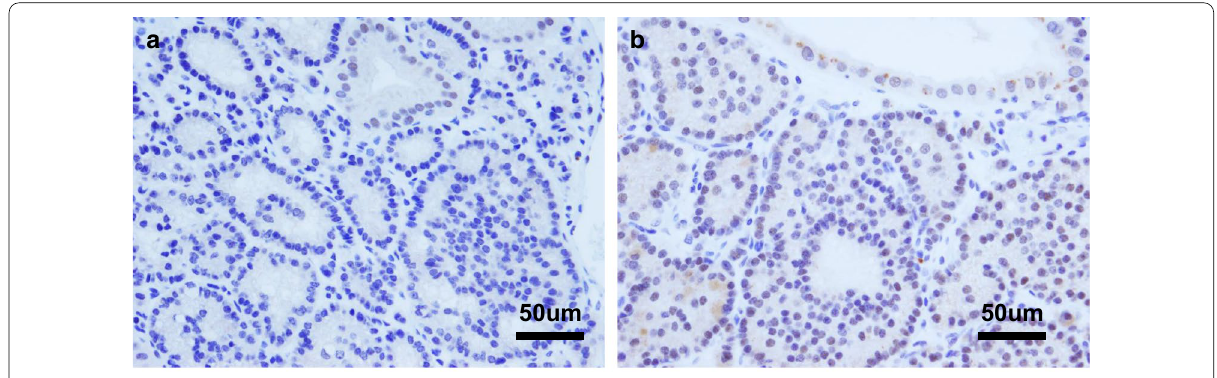
Fig. 5 Immunohistochemistry for a DAXX and b